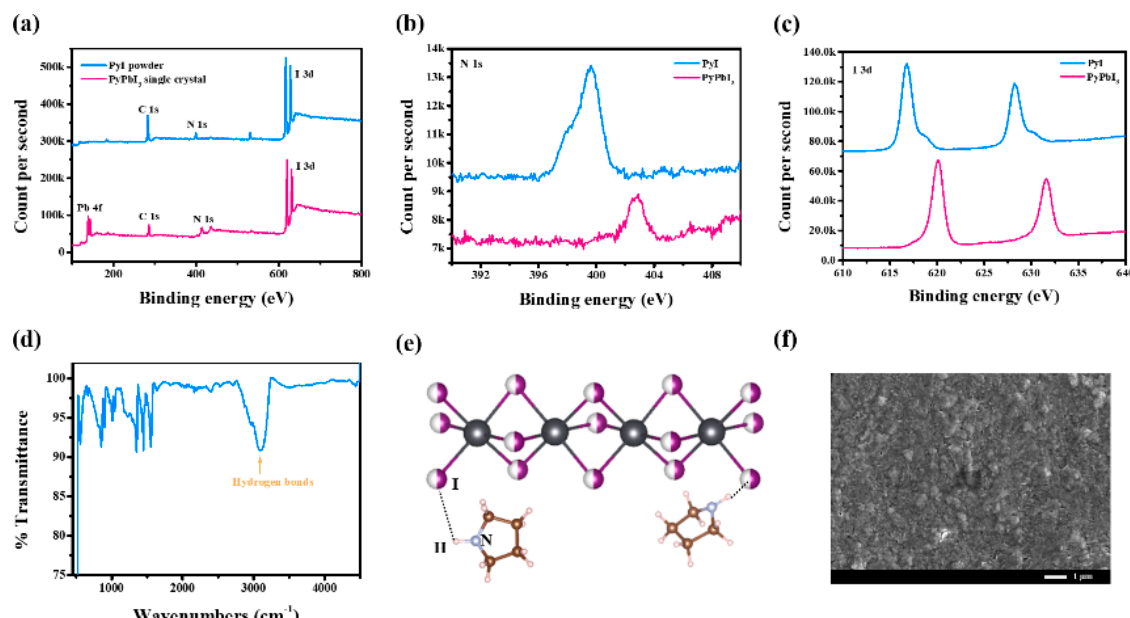
Figure 3. XPS results of the ( a ) whole spectrum, ( b ) N1s and ( c ) I3d of PyI and PyPbI 3 crystals. ( d ) FTIR spectra of PyPbI 3 . Reproduced from Ref [29] with permission from The Royal Society of Chemis-try. ( e ) Schematic illustration of hydrogen bonds in PyPbI 3 . ( f ) Planar SEM image of PyPbI 3 film.